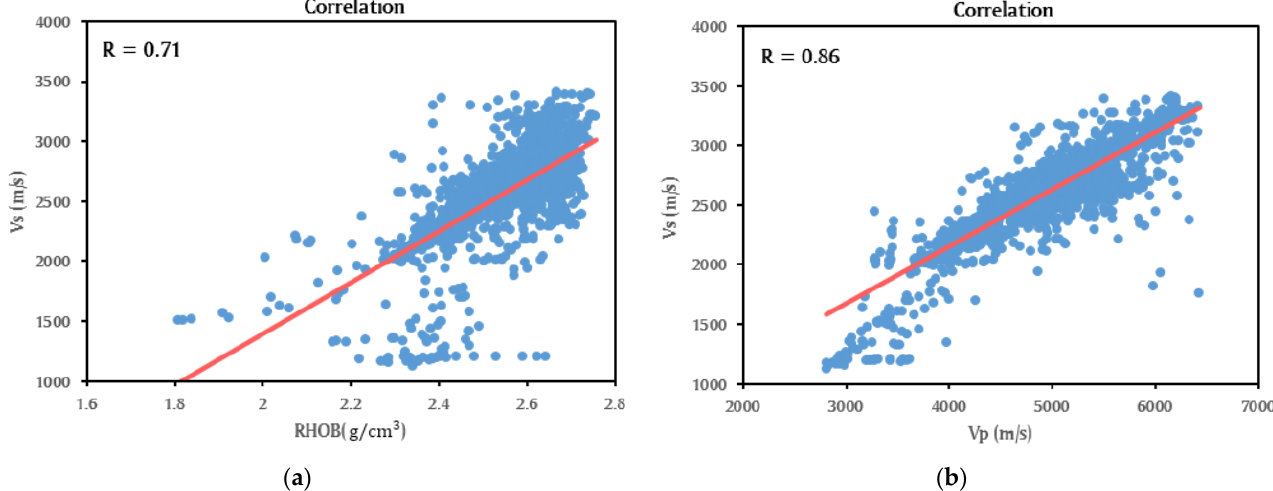
Figure 4. Representation of the correlation between inputs: ( a ) RHOB with R = 0.71 and ( b ) V P with R = 0.86 and target V S .